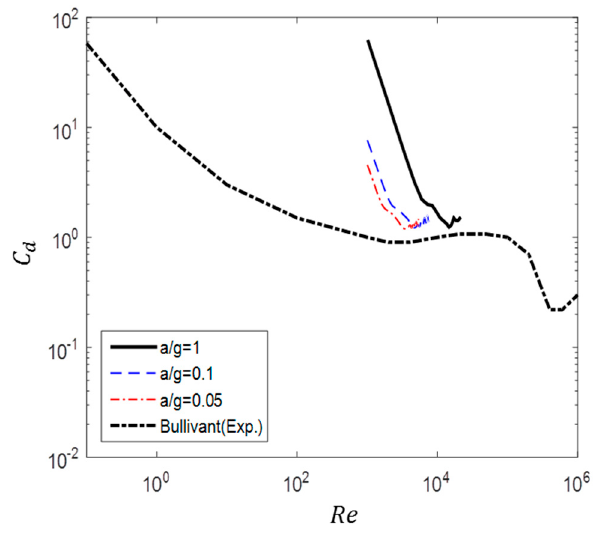
Figure 21. Comparison of drag coe ffi cient C d between non-accelerated flow (Bullivant [20]) and accelerated flow ( Re 0 = 1000 )